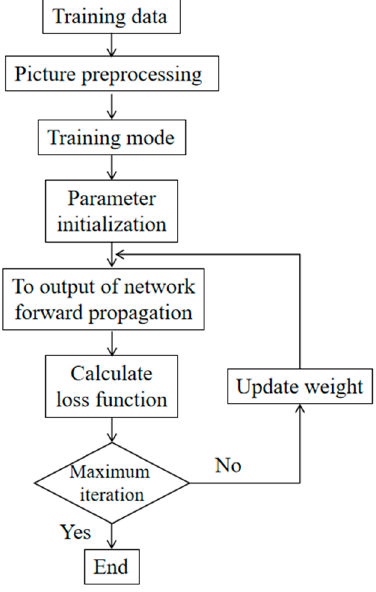
Figure 7. The model training process. The model testing process is shown in Figure 8.